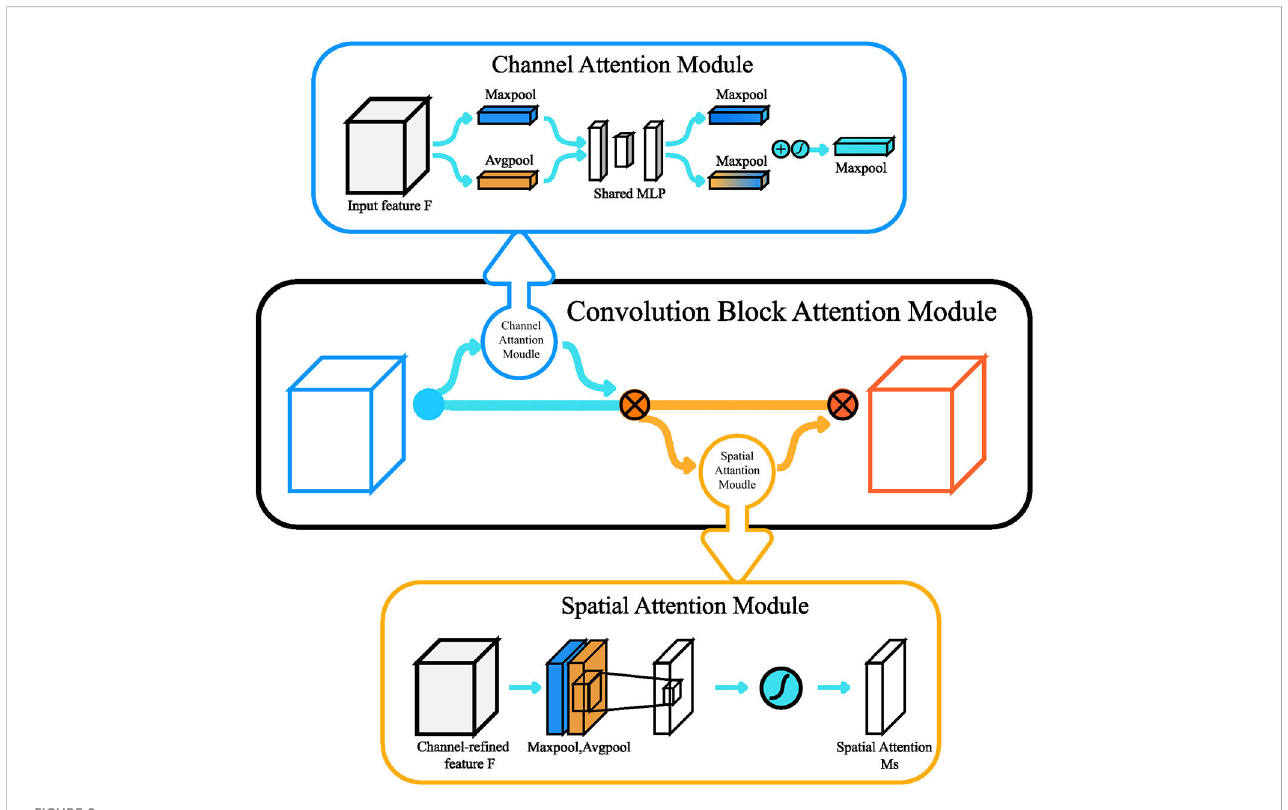
FIGURE 8 The structure of the CBAM module.